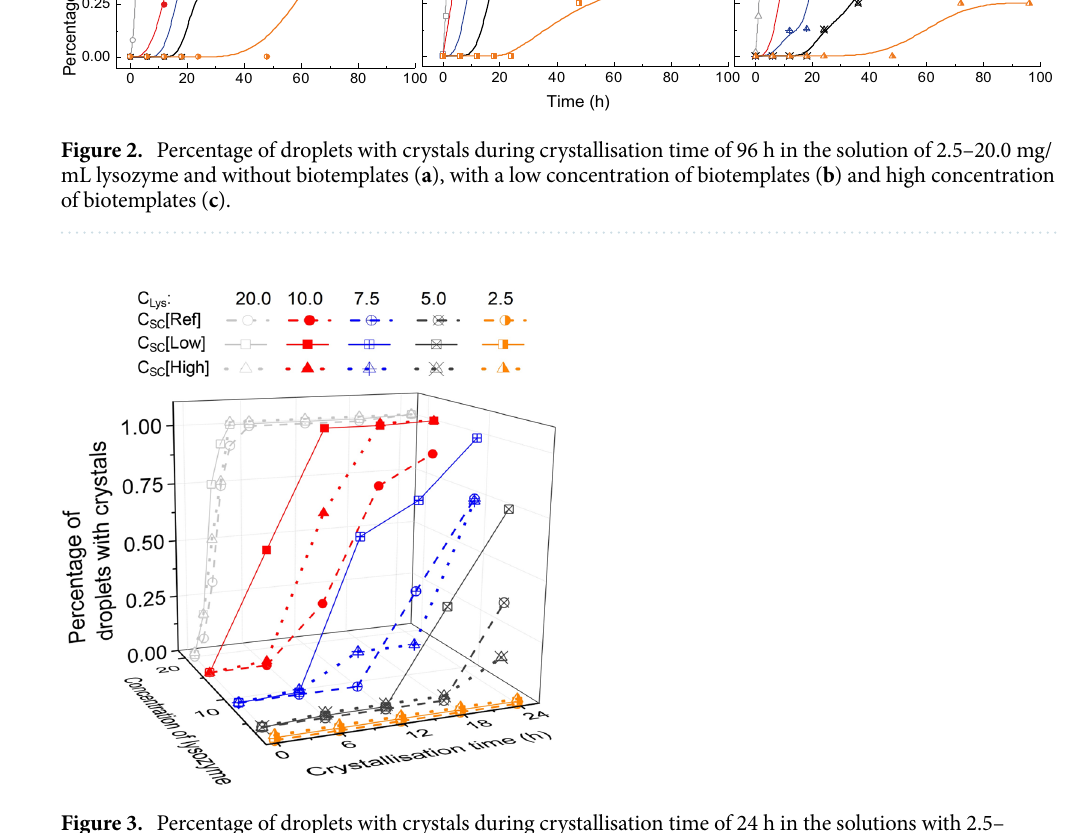
Figure 3. Percentage of droplets with crystals during crystallisation time of 24 h in the solutions with 2.5– 20.0 mg/mL lysozyme, and without and with a low and high concentration of